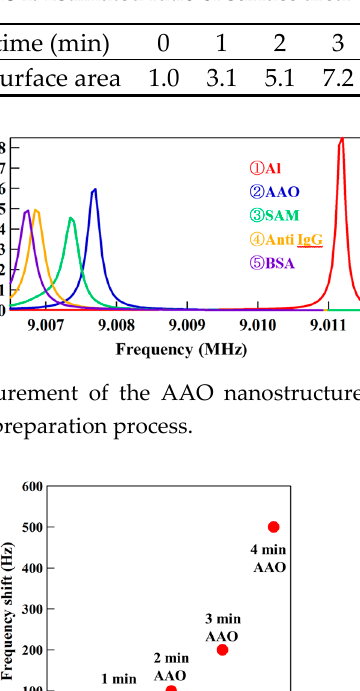
Table 1. Estimated ratio of surface area.